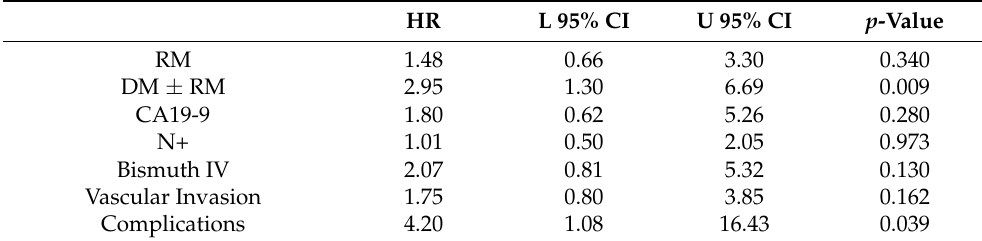
Table 8. Multivariate analysis for recurrence prognostic